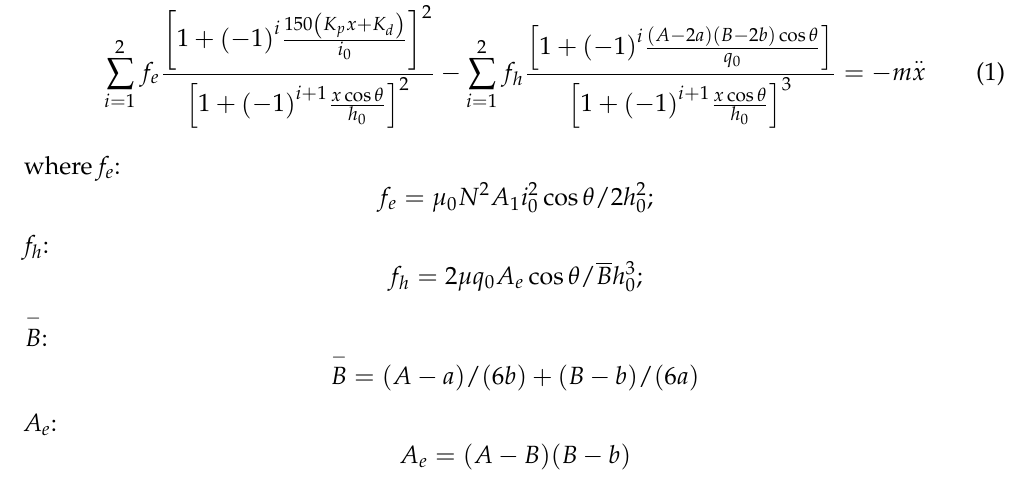
Table 1. Parameters of mathematical model of MLDSB. Parameter